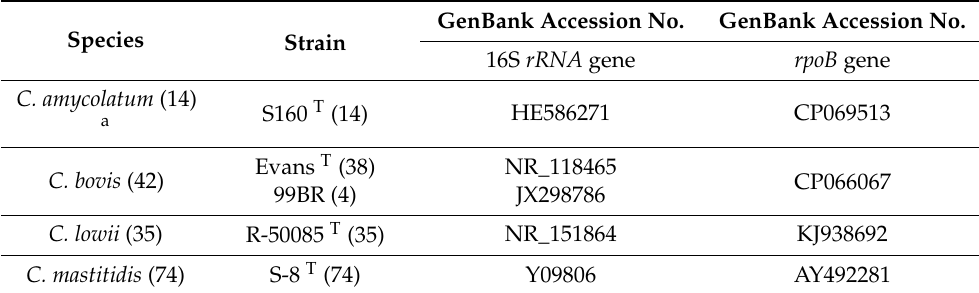
Table 1. Distribution of Corynebacterium in experimental mice in Korea. GenBank Accession No. GenBank Accession Species Strain